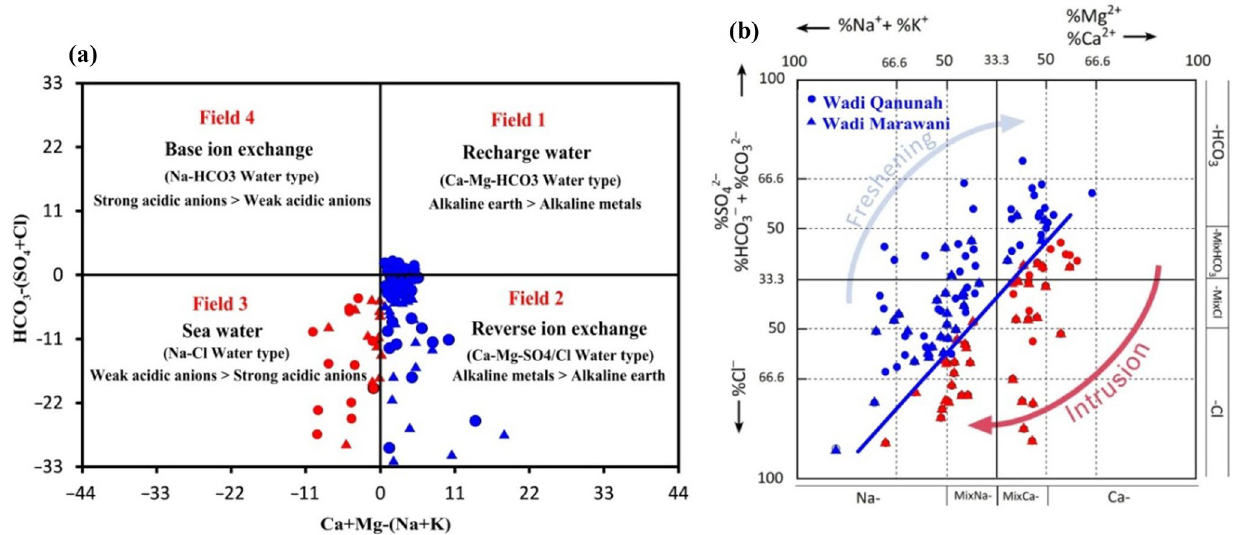
Fig. 8 Geochemical processes affecting on water quality along Wadi Qanunah and Wadi Marawani basins: a Chadha diagram and b hydrochemi- cal evolution facies diagram